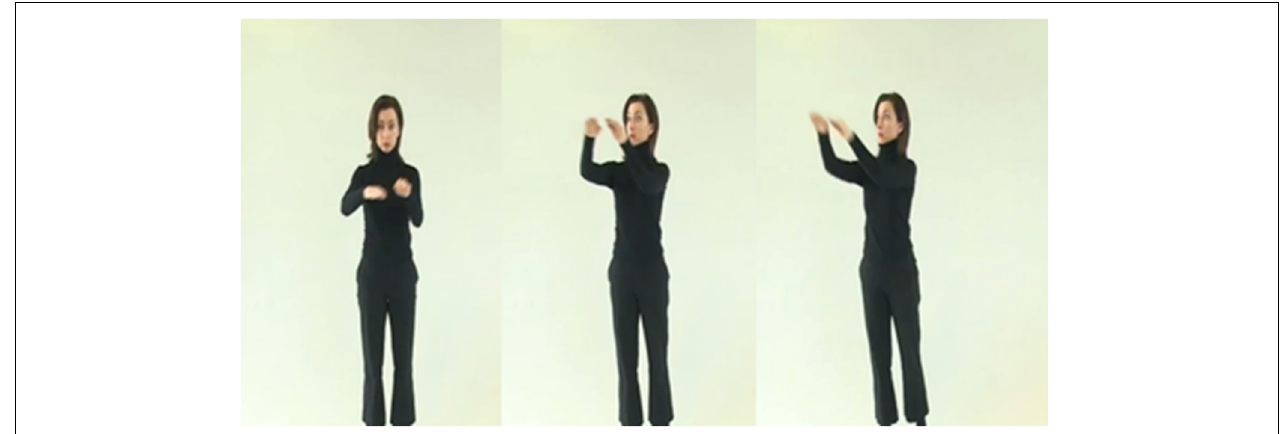
FIGURE 1 | Screenshots of a video with the actress while performing the gesture for the word “stair”.